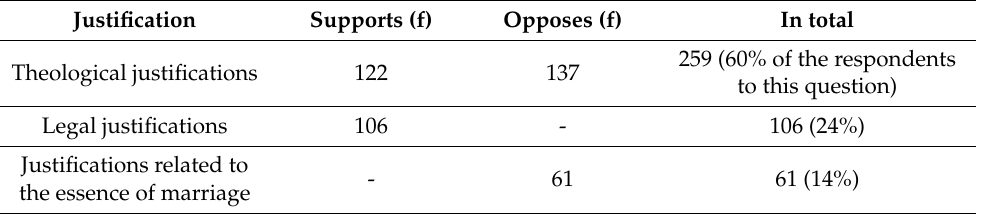
Table 1. Justifications for support or opposition to same-sex marriage in the church. (n = 433) (Each respondent was coded with one or more justifications, or no justifications at all, if not presented). Justification Supports (f) Opposes (f) In total 259 (60% of the respondents Theological justifications 122 137 to this question) Legal justifications 106 - 106 (24%) Justifications related to -